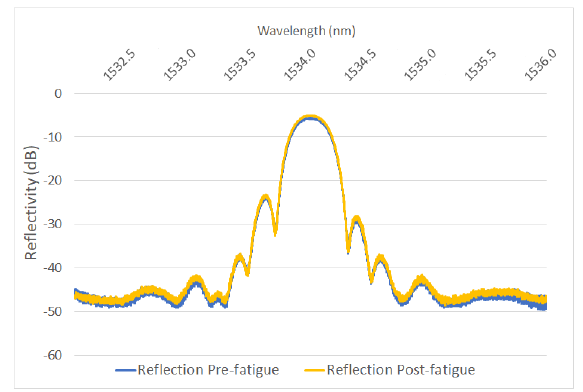
Figure 11. Pre- and post-fatigue reflection spectra comparison show identical reflective wavelength profile for a stripped and recoated FBG which survived the fatigue cycling.